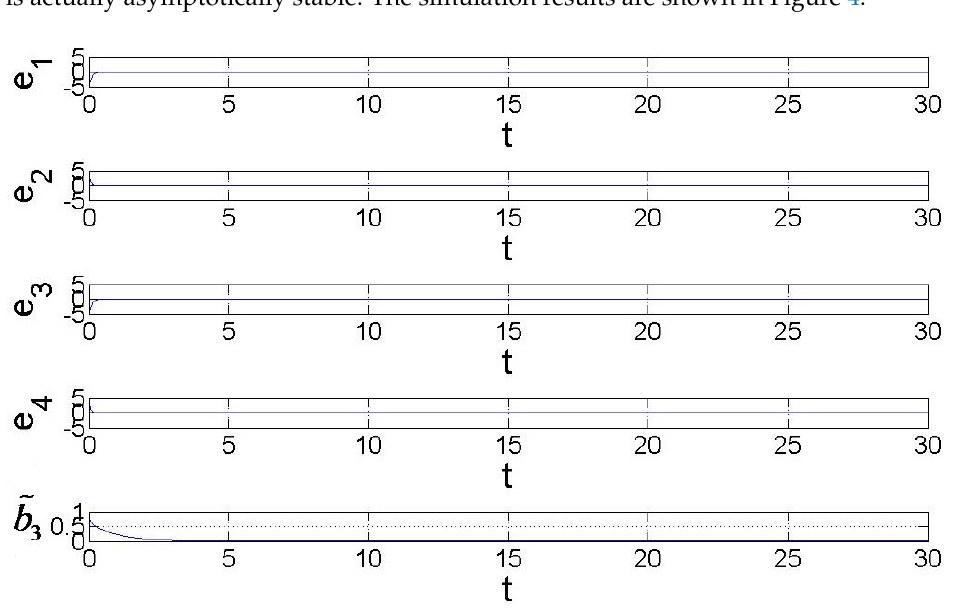
Figure 4. Time series for error states and error of parameters.